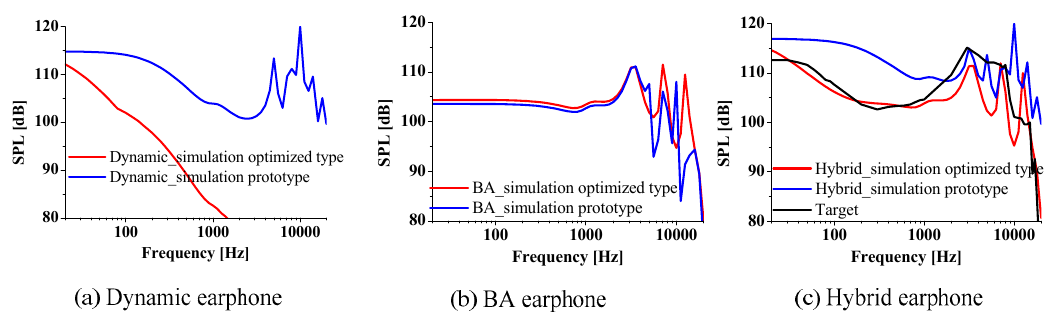
Figure 18. SPL of earphone with optimized acoustic tube and target SPL (simulation result).